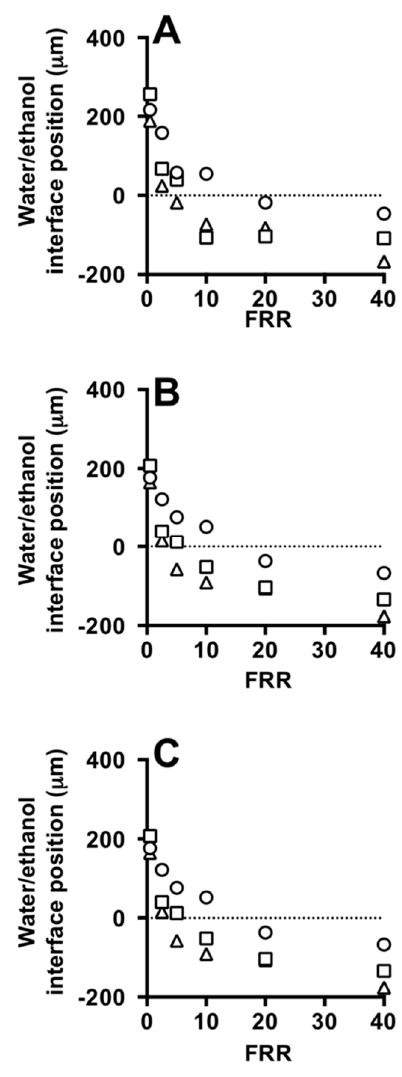
Figure 9. Effect of FFR on the water/ethanol interface position at different TFRs, measured from experiments ( A , B ) and simulations ( C ) using #chip2-YJ. TFR was set to 18.75 (circles), 37.50 (squares) and 75.00 (triangles) µL/min. Experiments were carried out in the absence ( A ) and in the presence of liposome forming lipids ( B ). Data represent the average of 3 measurements ± SD (the maximum standard deviation is equal to 0.5).